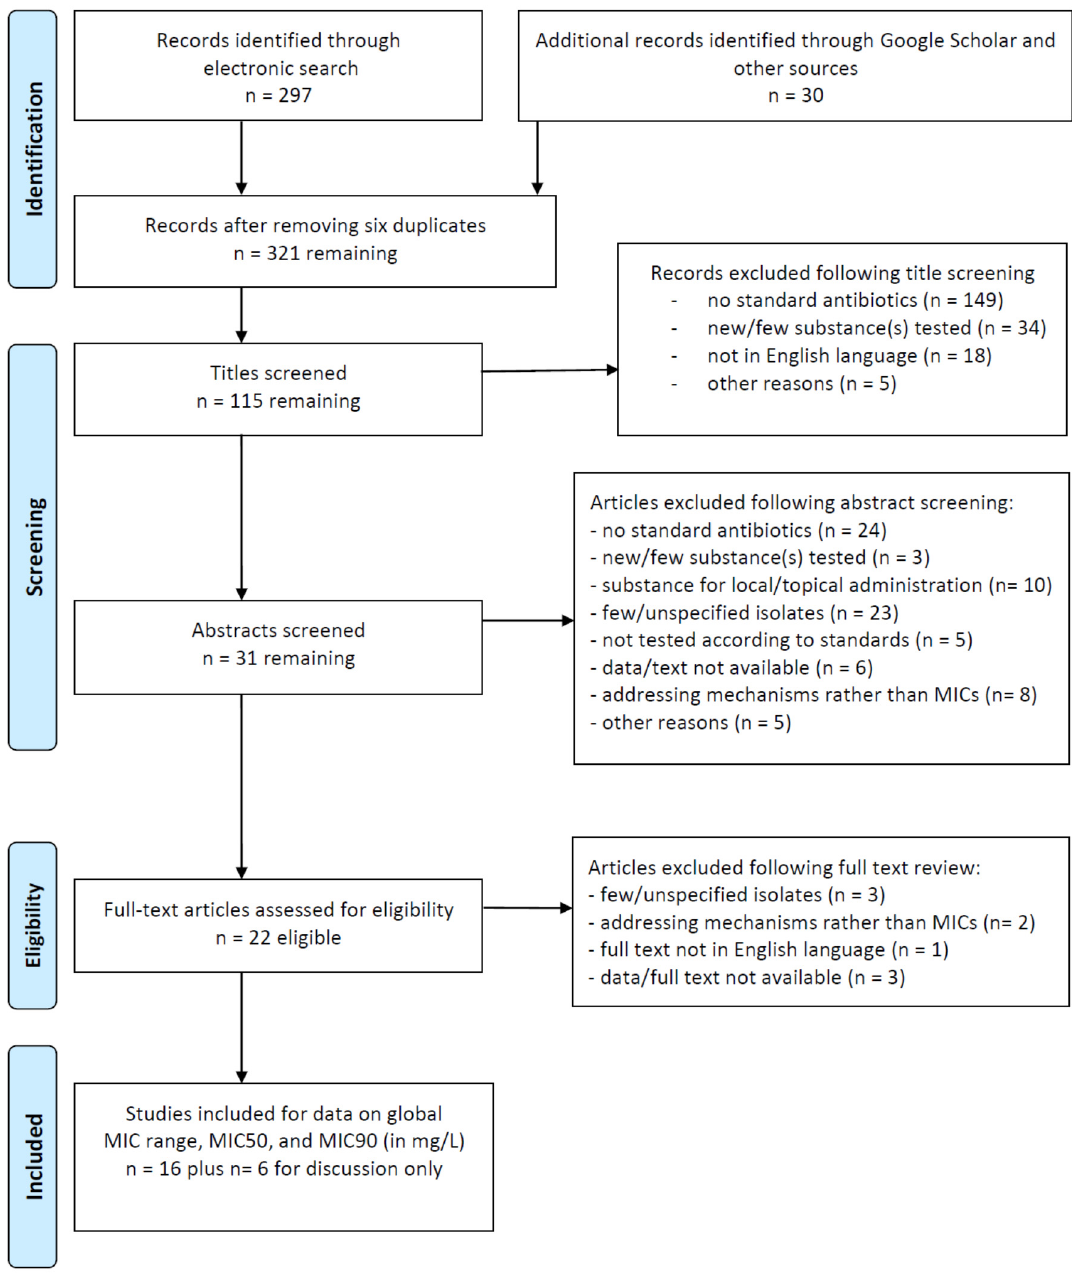
Figure 1. Flow diagram of the search for Porphyromonas gingivalis -/minimal inhibitory concentration (MIC)-related articles (based on the PRISMA checklist).